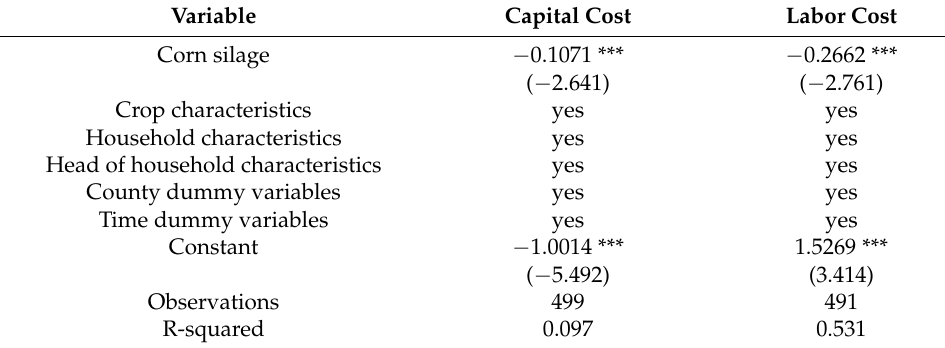
Table 4. Effects of corn silage on farmers’ production